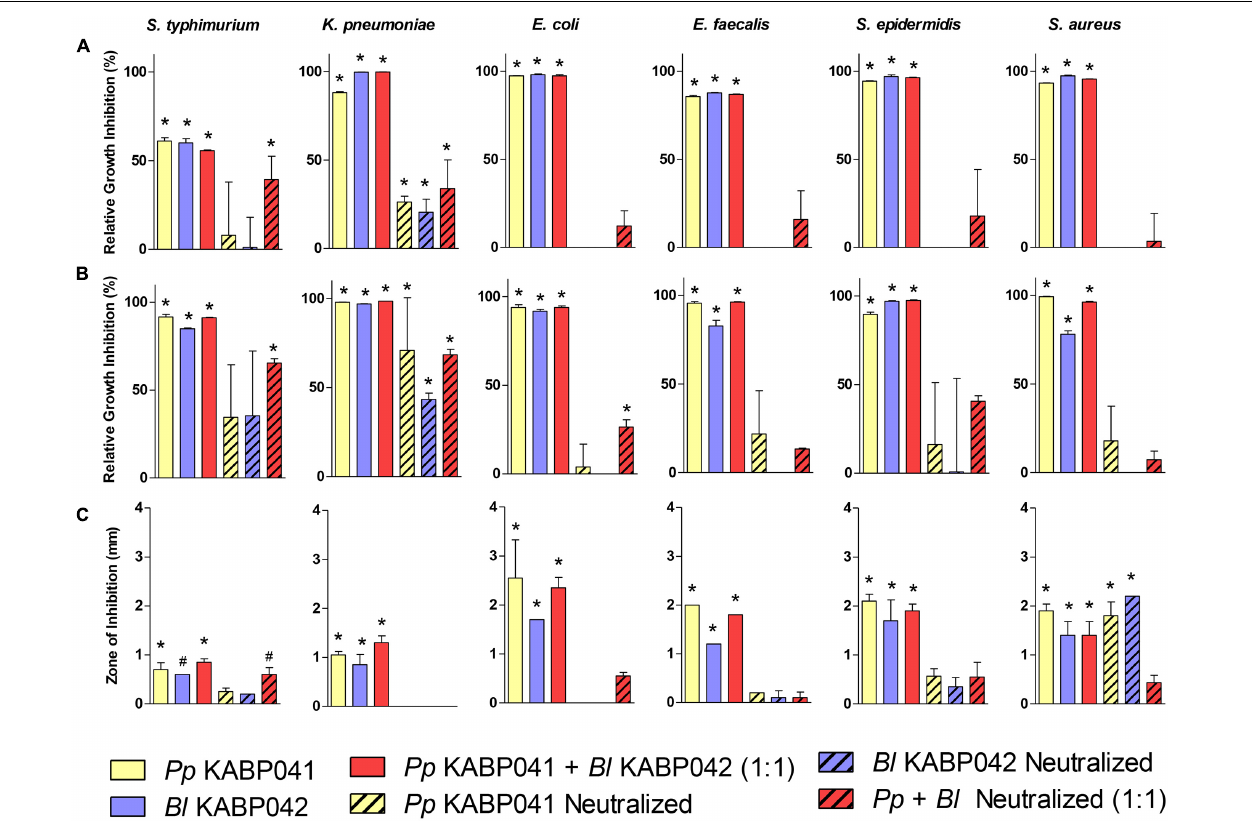
FIGURE 3 | Antagonism activity of P. pentosaceus KABP041 ( Pp KABP041), B. longum KABP042 ( Bl KABP042), and a combination 1:1 of both strains ( Pp KABP041 + Bl KABP042) against diverse Gram-positive and Gram-negative bacterial pathogens. Percentage of growth inhibition (Area Under the Curve) of pathogens cultured in supernatants of (A) probiotic mono-cultures, and (B) probiotic + pathogen co-cultures relative to pathogen’s growth in control condition. (C) Growth inhibition of bacterial pathogens measured in mm determined by the soft agar overlay assay. Free pH and neutralized conditions are indicated. Statistical analyses were performed by the one-way ANOVA with Bonferroni’s Multiple Comparison Test. * p < 0.001; # p <